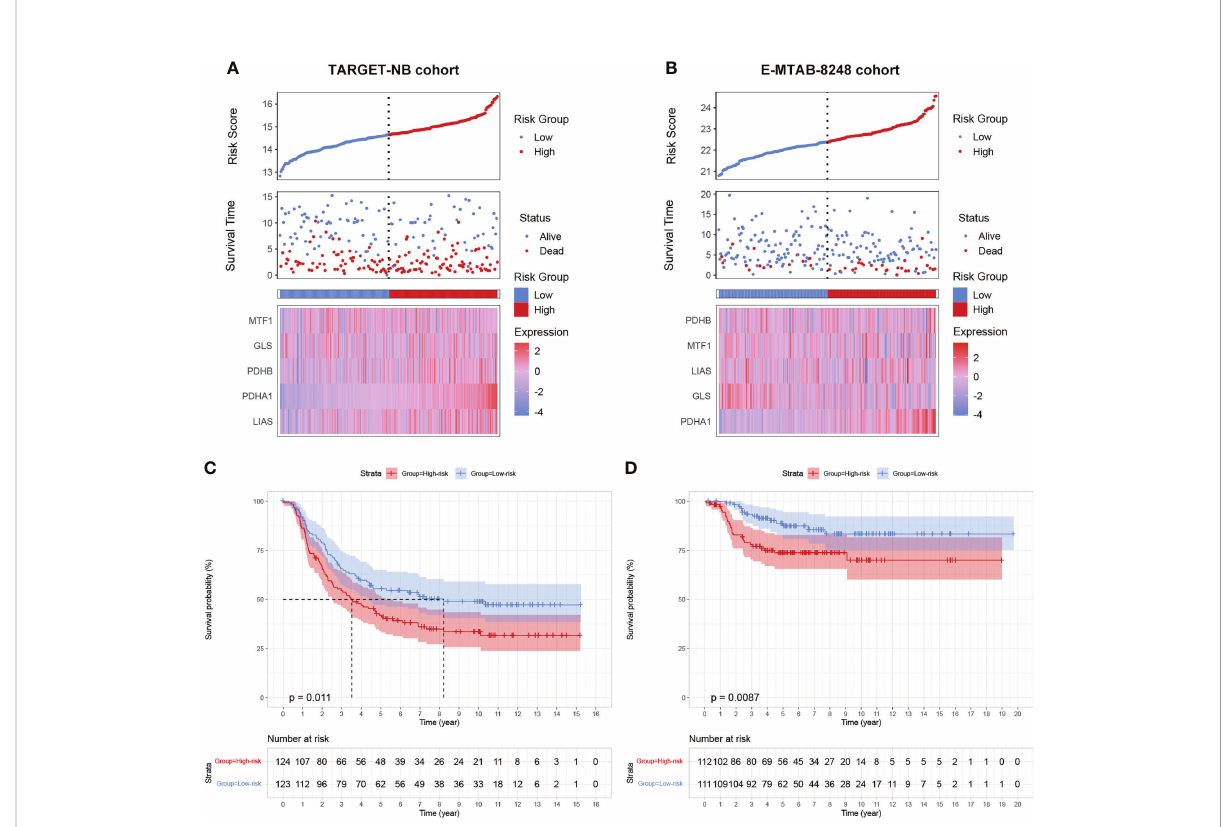
FIGURE 4 validation of the cuproptosis signature in two independent NB cohorts. (A, B) Distribution of the riskscore, the associated survival data, and the mRNA expression heatmap of the gene signature in the TARGET-NB and E-MTAB-8248 cohort. (C, D) Patients in the high-risk subgroup exhibited worse survival compared to those in the low-risk subgroup both in the TARGET-NB and E-MTAB-8248